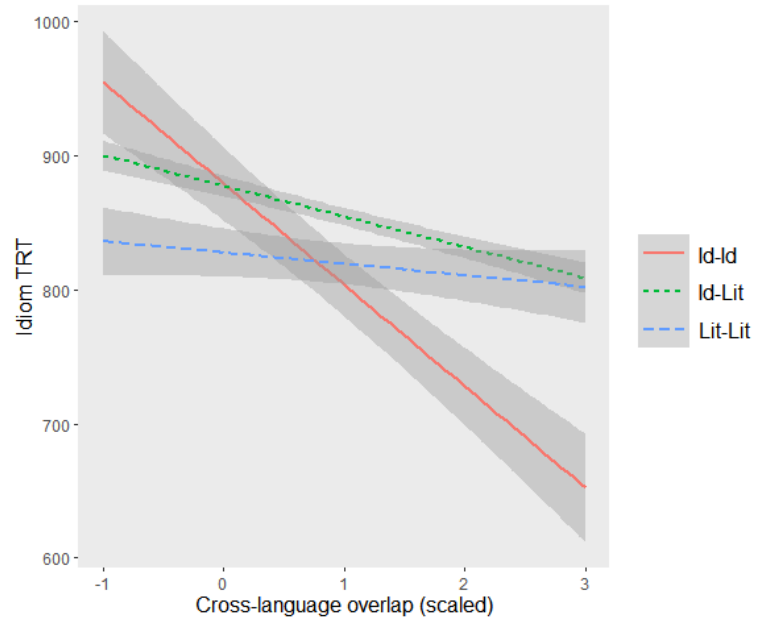
Figure 2. Partial effects plot of total reading time of the whole idiom region as a function of cross- language overlap ( x -axis) for the Idiomatic–Idiomatic (Id-Id), Idiomatic–Literal (Id-Lit) and Literal– Literal (Lit-Lit) conditions. Error shadings reflect ± 1 standard error of the mean.